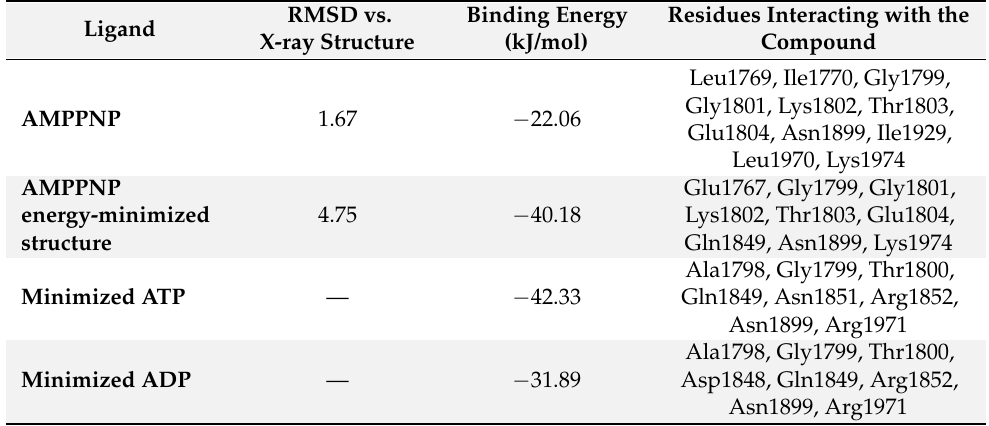
Figure 6. AMPPNP in the AAA1 binding site of dynein. ( A ) The linker and the AAA1 and AAA2 subunits of dynein and illustration of their inter-subunit binding site. ( B ) Docking solution of the minimized AMPPNP in the AAA1 binding site of the minimized conformation from the yeast motor AMPPNP crystal structure (4W8F). The docking solution is in stick representation, while the crystal structure of AMPPNP is in ball-and-stick representation. ( C ) The energy-minimized AMPPNP in the AAA1 binding site of the energy-minimized structure of yeast motor AMPPNP (4W8F) superimposed with the docking solution of the reference ligand, AMPPNP, from the crystal structure. ( D ) Crystal structure of AMPPNP docked in the AAA1 binding site of the crystal structure of yeast motor AMPPNP (4W8F). The calculated conformations (black- gray) ball-and-stick representations and the crystal structure of AMPPNP (reference, green ball-and-stick representation). Nonessential hydrogen atoms are not shown for simplicity. Table 5. Binding properties of the nucleotides’ conformation obtained from the in silico